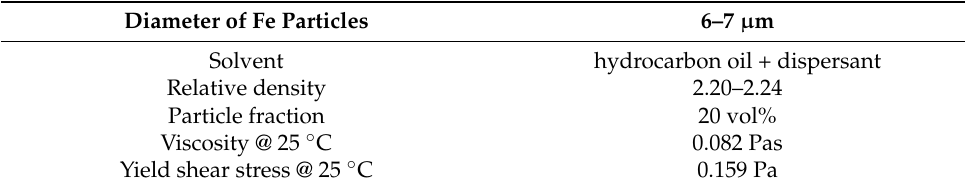
Table 3. Properties of the standard material.